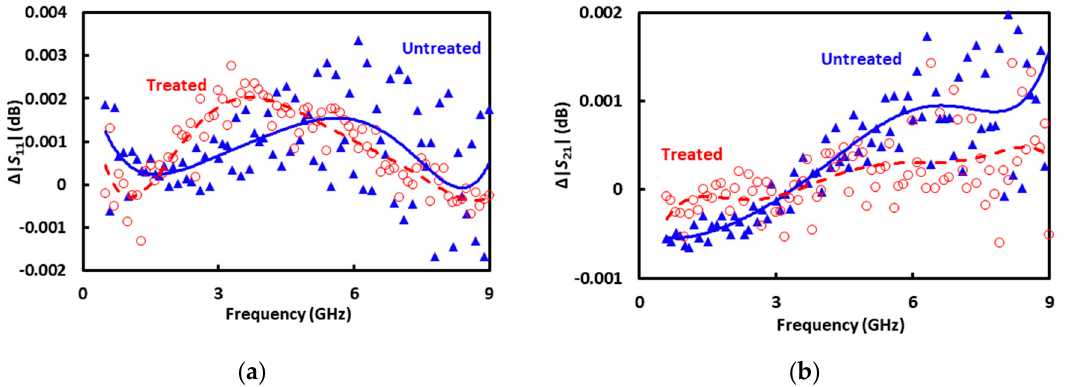
Figure 9. Average ( a ) Δ | S 11 | and ( b ) Δ | S 21 | measured on treated ( ○ ) and untreated ( ▲ ) cells. Trend lines by 6th-order polynomial fitting are shown to aid visibility.